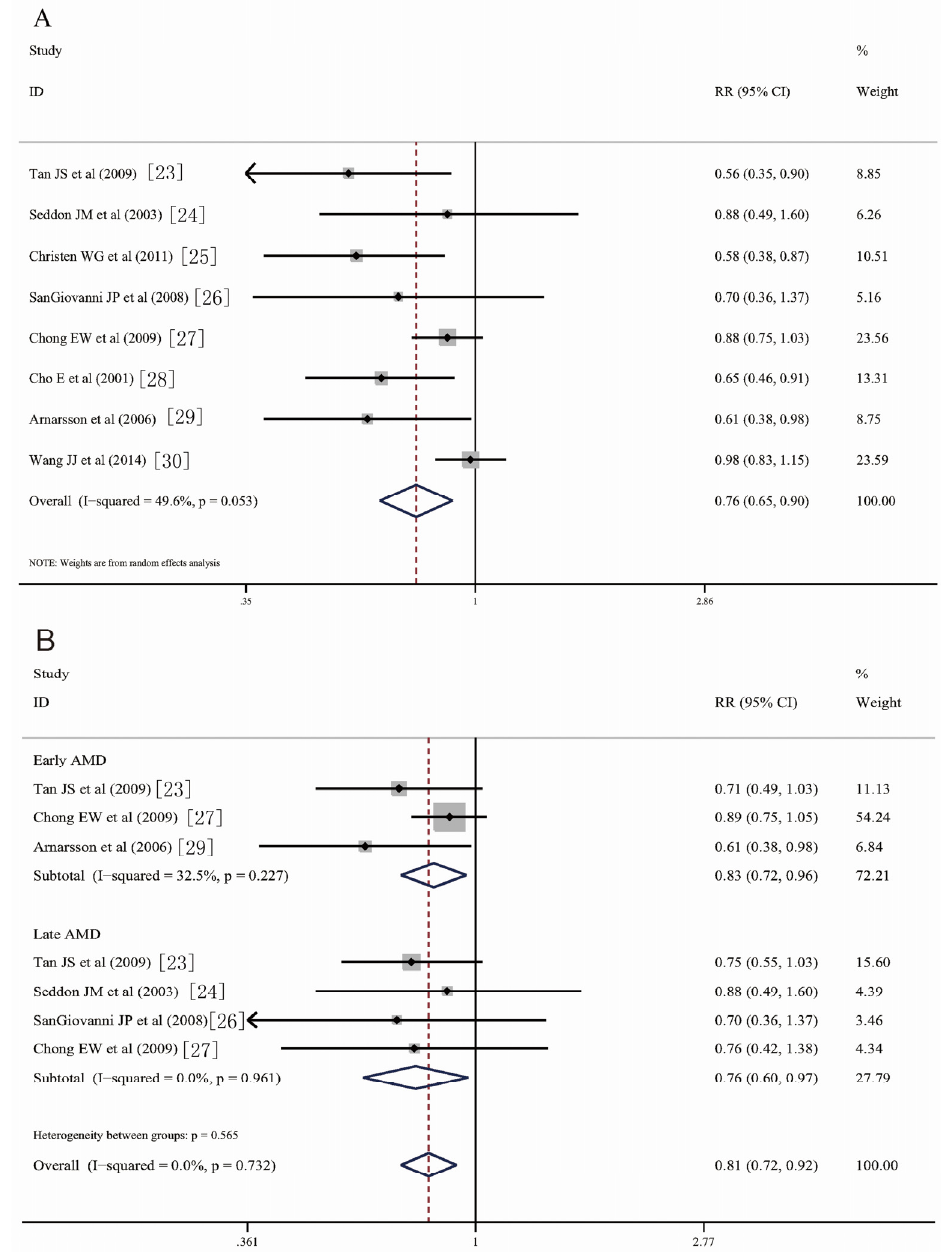
Figure 2. Forest plot of risk estimates of the association between fish intake and risk of age-related macular degeneration (AMD). ( A ) fish consumption and risk of any kind of AMD; ( B ) fish consumption and early and late AMD, through consulting the reference lists of relevant reviews and articles. The size of the shaded square is proportional to the percent weight of each study. Horizontal lines represent 95% confidence intervals (CIs). The diamond data markers indicate pooled odds ratios (ORs).